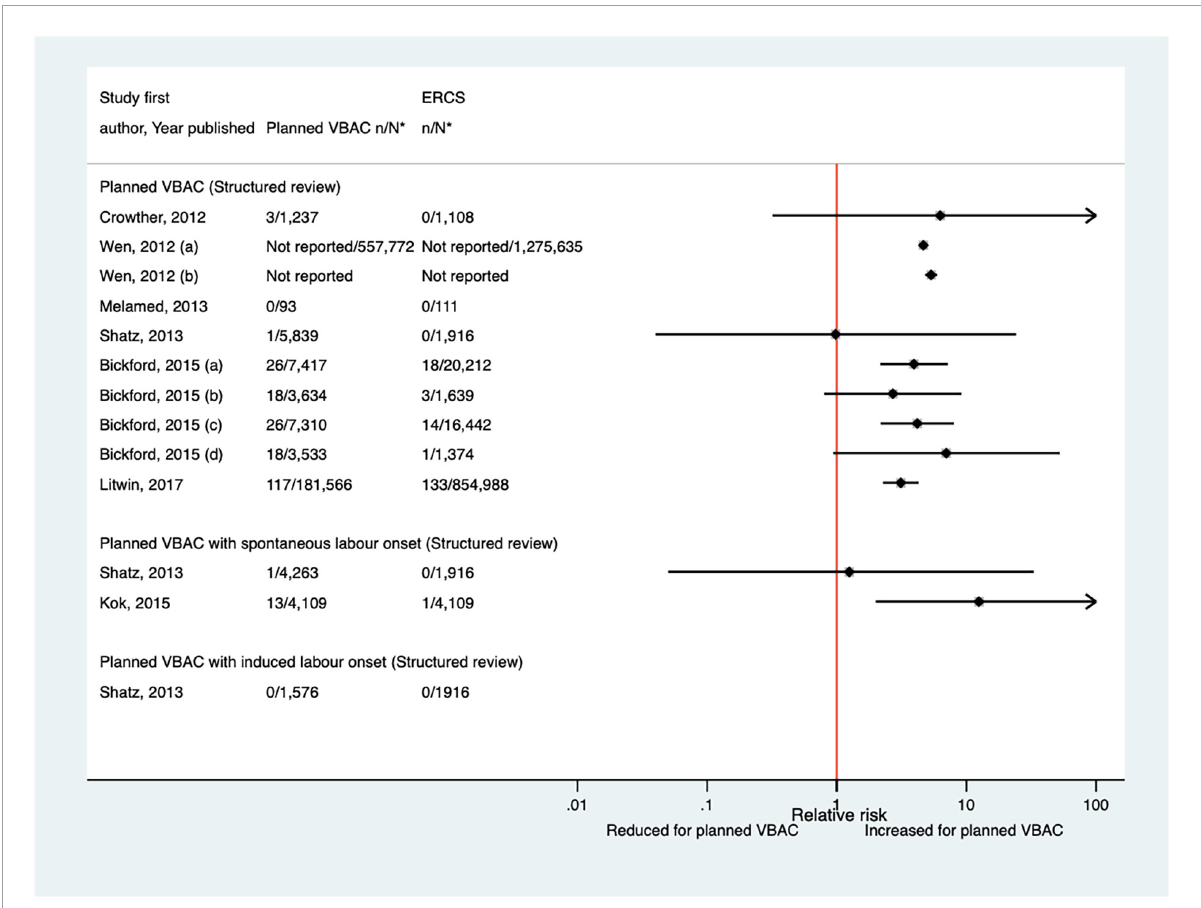
FIGURE12 Risk of birth trauma for planned VBAC vs. ERCS. ∗ n , number in group with the outcome; N , Total number in group. Wen et al. (42) (a) risk in total study population, (b) risk in infants born to “low-risk” women without pre-existing medical problems, pregnancy complications, preterm birth or an infant with low birth weight or congenital anomaly; Bickford and Janssen (50) (a) risk in women with 1–2 prior CSs only, (b) risk in women with 1–2 prior CSs and ≥ 1 prior VB, (c) risk in women with 1 prior CS only, (d) risk in women with 1 prior CS and ≥ 1 prior VB. CS, cesarean section; ERCS, elective repeat cesarean section; VBAC, vaginal birth after previous cesarean; VB, vaginal